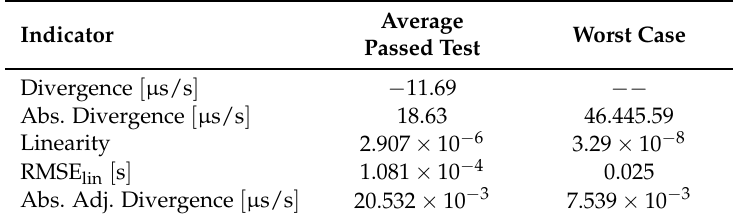
Table 4. Results of the synchronization